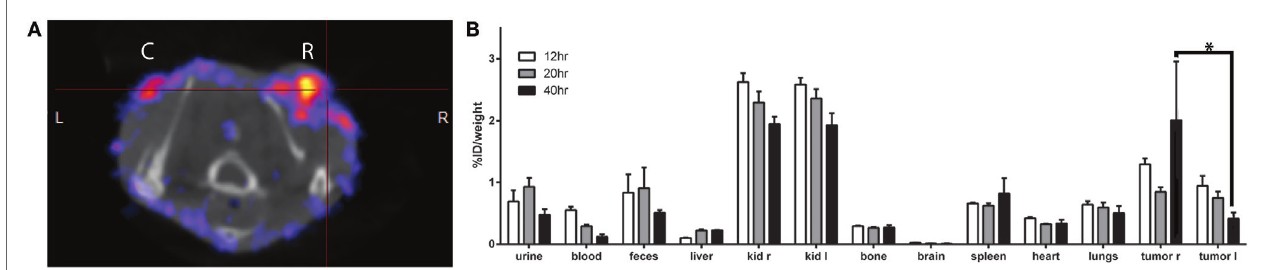
FigUre 6 | sPecT-cT of [ 111 in]DTPa-hQ4-DTPa biodistribution . (a) Representative transversal SPECT–CT image of the mouse with control (C) and irradiated (R) tumor 40 h following injection. (B) Measurement of [ 111 In]DTPA-HQ4 biodistribution in% ID/weight in different organs at various time points (12, 20, and 40 h post injection), where irradiated tumor (“tumor r ”) shows higher accumulation of the probe compared to control (“tumor l ”) ( n = 3, * p < 0.05).